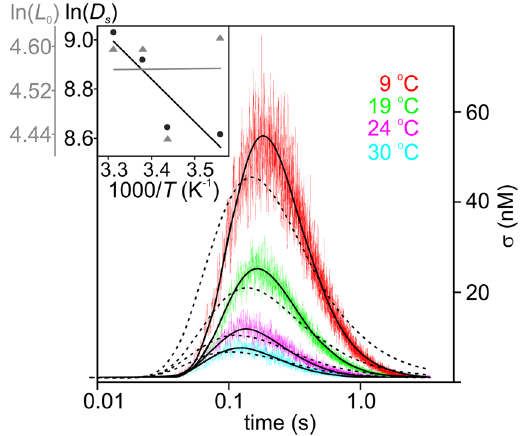
Figure 4. The quasi-equilibrium model (compare equation (3) ) does not fit the data for d ≪ L 0 (dashed line, for parameters see Supplementary Table S1) if the surface-to-bulk release reaction is assumed to be one dimensional ( α = 1). As in the case of the non-equilibrium model we took the finite sizes of proton release and detection areas into account (equation (S4)). The experimental data (colored lines) were taken from Fig. 3. The assumption α = 3 (solid black lines) yielded a satisfactory fit. Inset: The global fit of the quasi-equilibrium model ( α = 3) to the traces measured at 80, 90, 100, and 110 µ m produced a temperature independent L 0 of roughly 100 µ m. The corresponding Arrhenius plot of D s (in units of µ m 2 s − 1 ) revealed Δ H ‡ l = 5.8 ± 2.0 k B T and a pre- exponential factor A l = (3.3 ± 0.5) × 10 6 µ m 2 s − 1 . These values are essentially identical to those obtained from the non-equilibrium model in Fig.